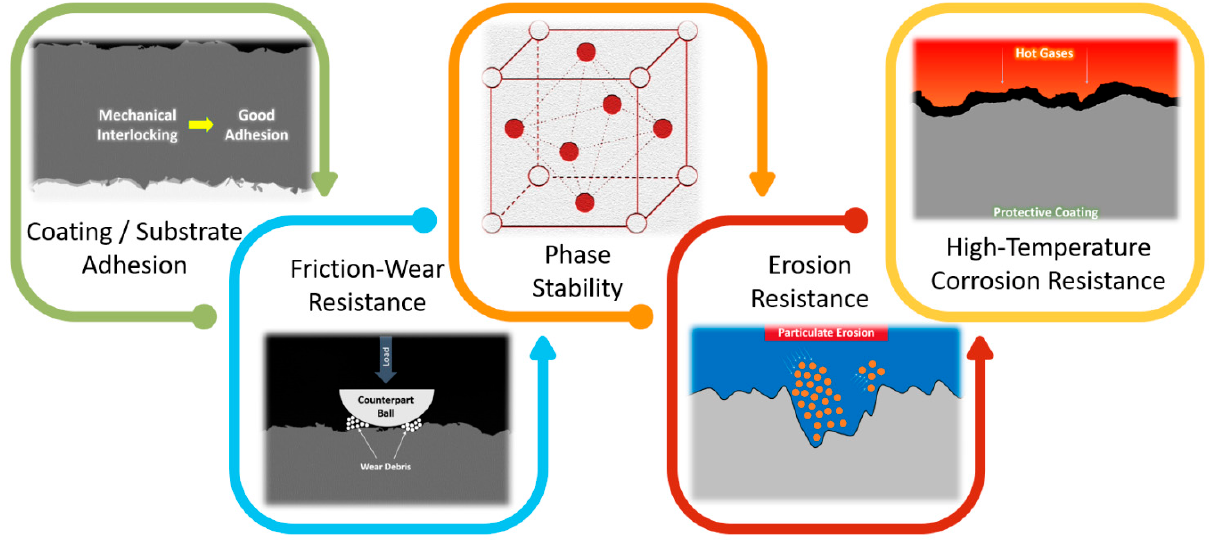
Figure 1. Schematic representing the main five characteristics of coatings required for the high-temperature tribological applications.